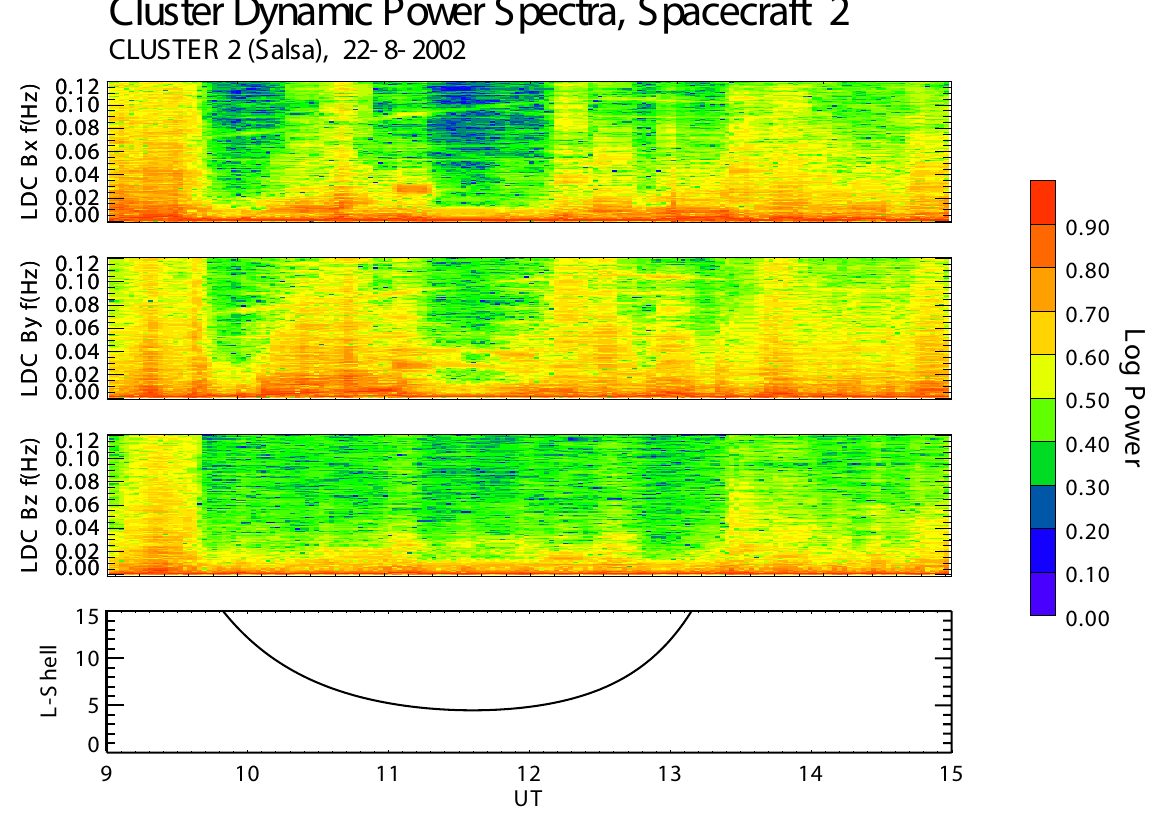
Fig. 4. The dynamic power spectrum of magnetic field data from spacecraft 2 of cluster for 09:00–15:00 UT. The upper, three panels represent magnetic local dipole coordinate (LDC) X , Y and Z components respectively (the coordinate system is been described in the text), with normalised logarithmic Fourier spectral power being represented by a colour scale. The bottom panel shows the spacecraft L